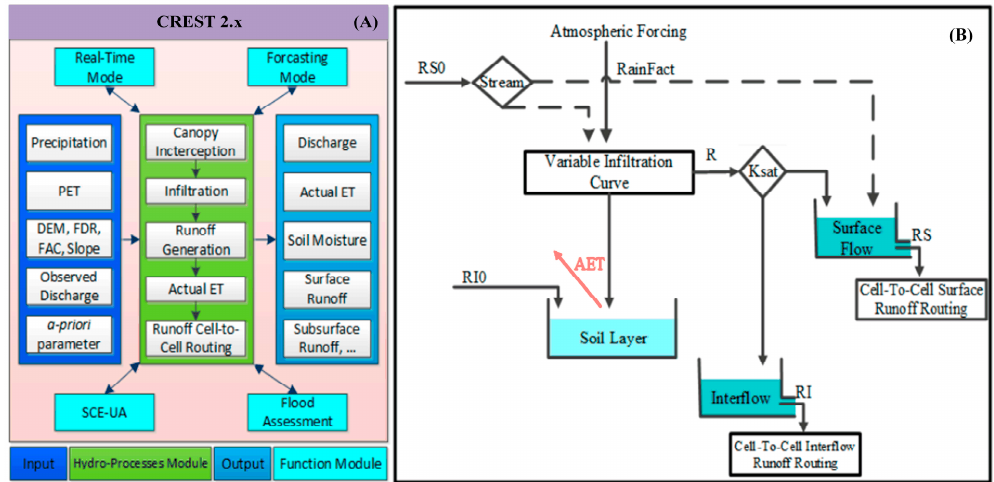
Figure 1. ( A ) The framework of the coupled routing and excess storage (CREST) model version 2.x and ( B ) vertical profile of hydrological processes in a grid cell [25]. AET: actual evapotranspiration;